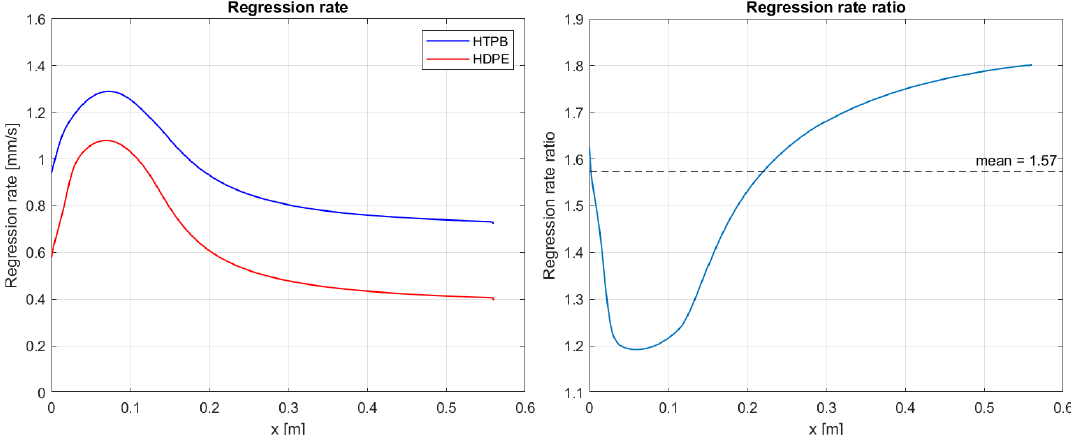
Figure 16. Comparison between HDPE and HTPB regression rates obtained from the CFD